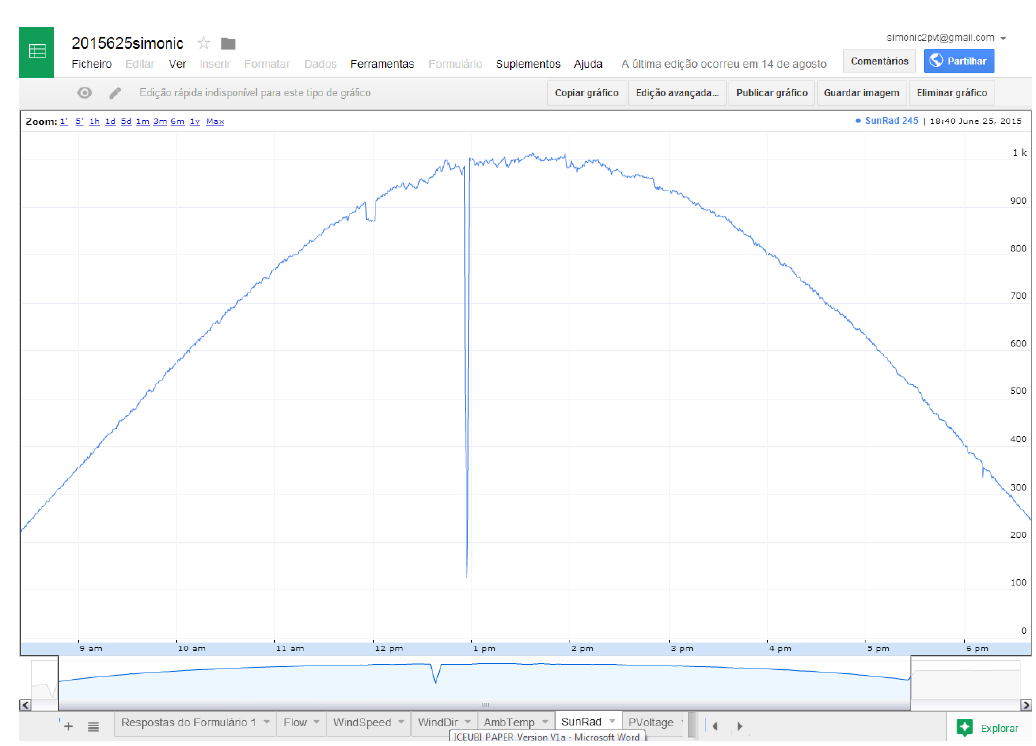
Figure 5: Print screen of the graph for solar